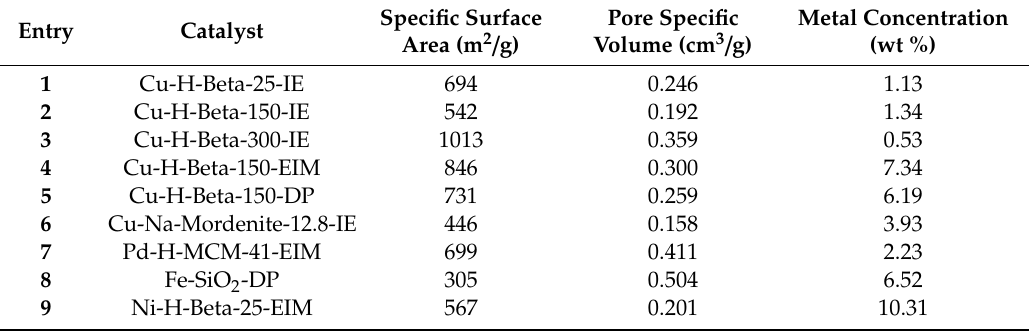
Table 2. Specific surface area, pore volume, and metal (Cu, Pd, Fe, Ni) content of the catalysts employed in the ozonation experiments.